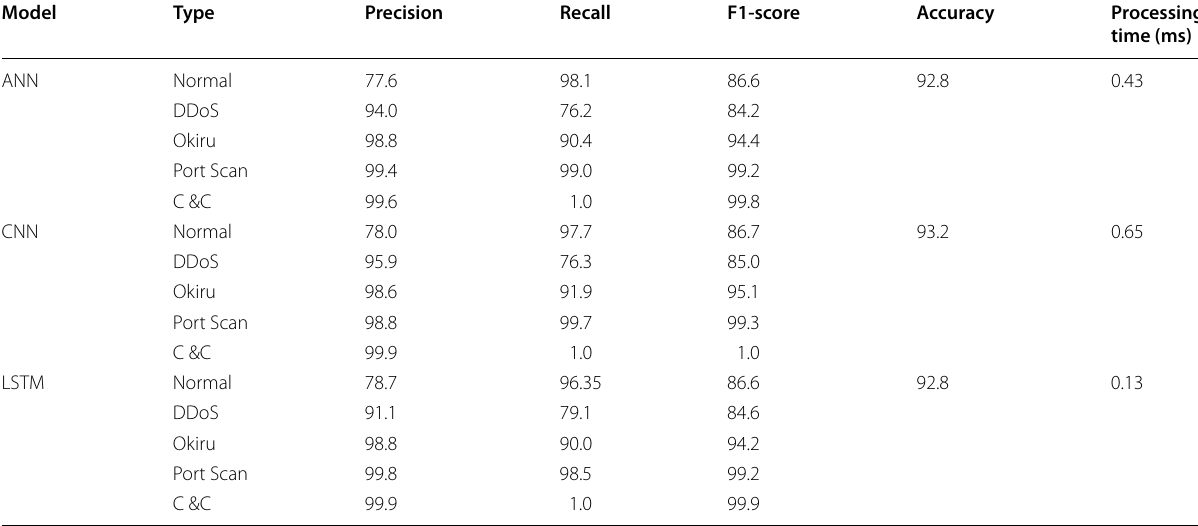
Table 8 Results for multi-classification without using lambda architecture—5 traffic types: 1 for benign and 4 for attacks Model